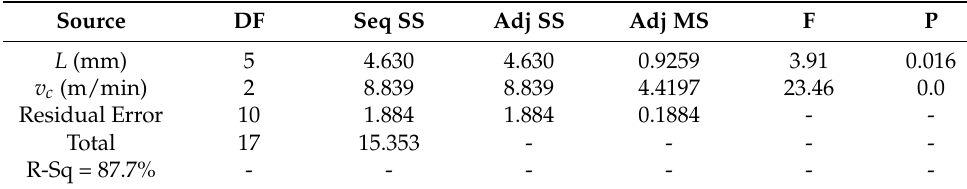
Table 11. ANOVA statistical analysis for Ra ( µ m).